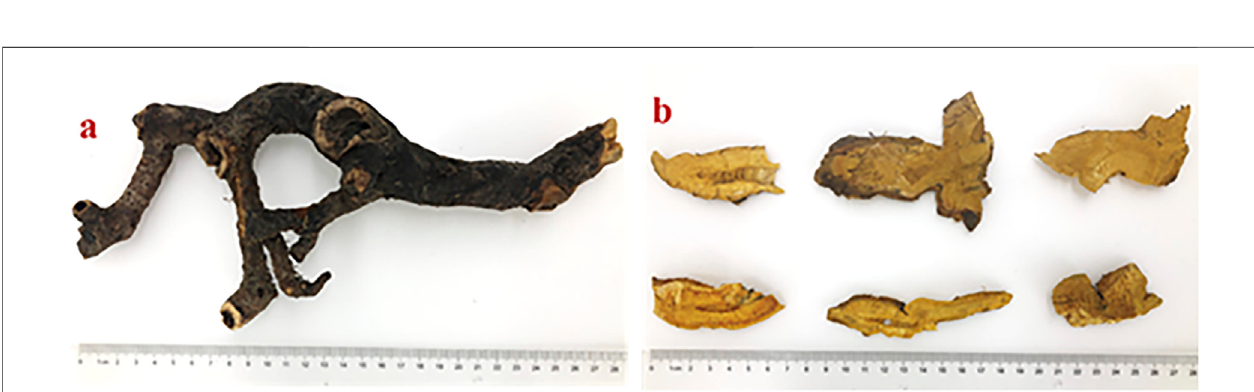
FIGURE 2 | Schematic diagram of medicine material crude slices of HZ. (A) Whole medicinal parts and (B) sliced medicinal parts.